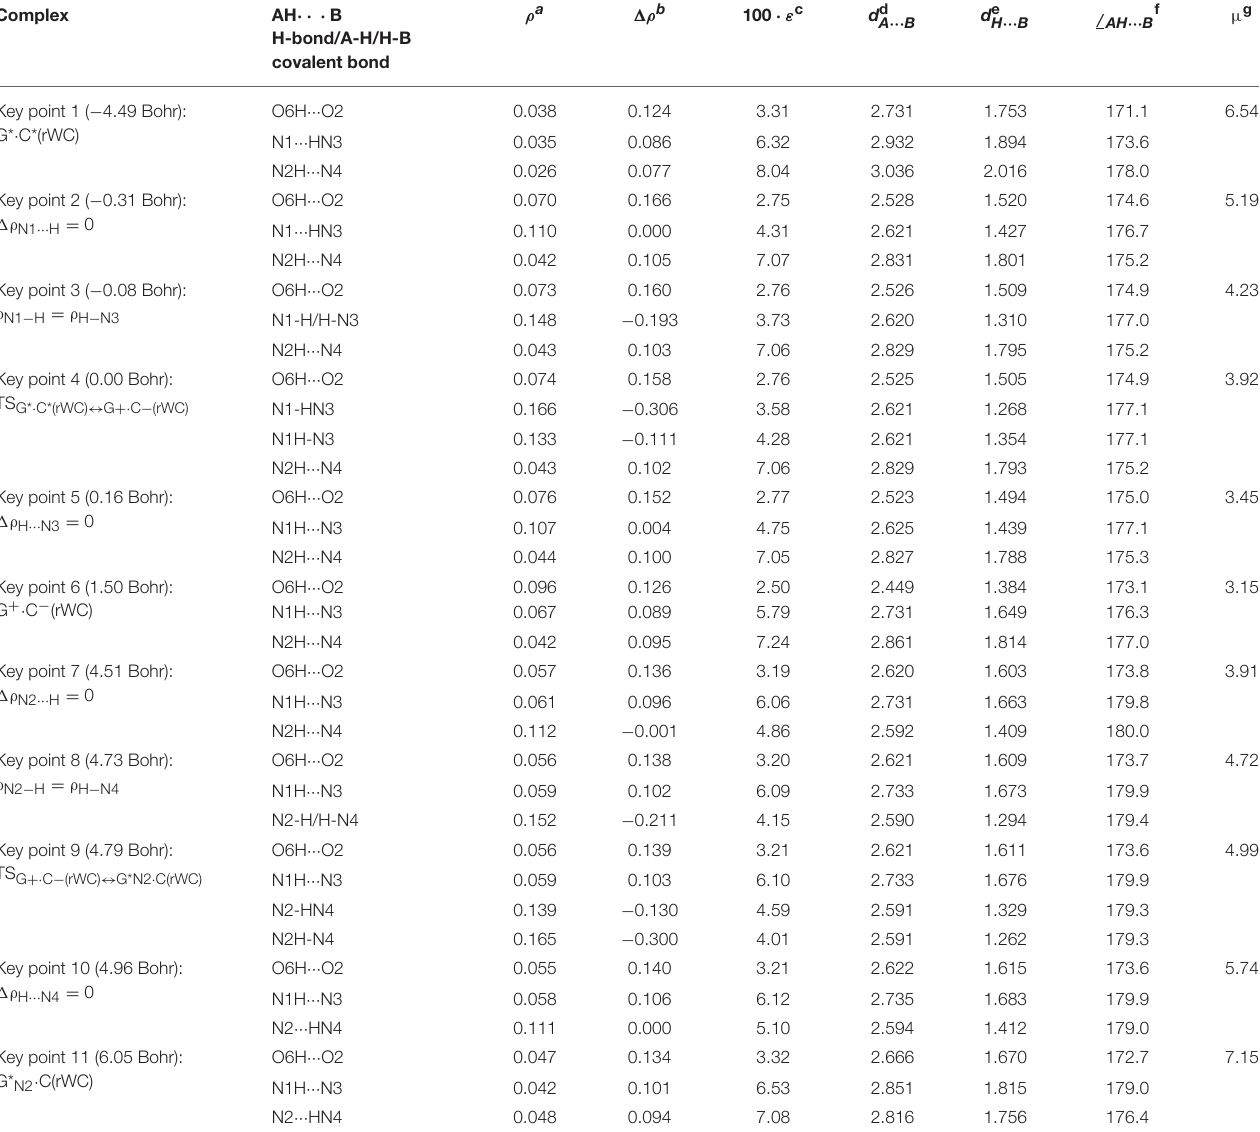
TABLE 4 | Electron-topological and structural characteristics of the specific intermolecular bonds revealed in the 11 key points and the polarity of the latters along the IRC of the II.